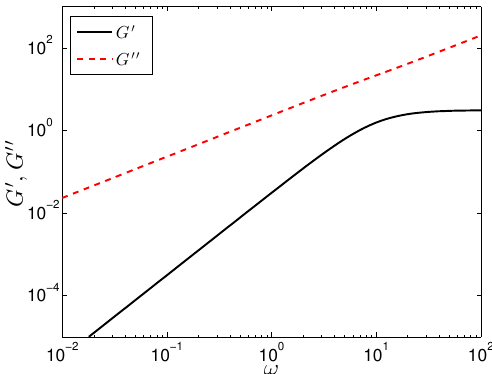
Figure 1. Storage, G (cid:48) , and loss, G (cid:48)(cid:48) , moduli as a function of frequency, ω . Parameter values are: S = 10 − 1 , c 7 = − 0.47, c 9 = 0, η S = 1, f ( φ ) = 1.0957, k 4 = −